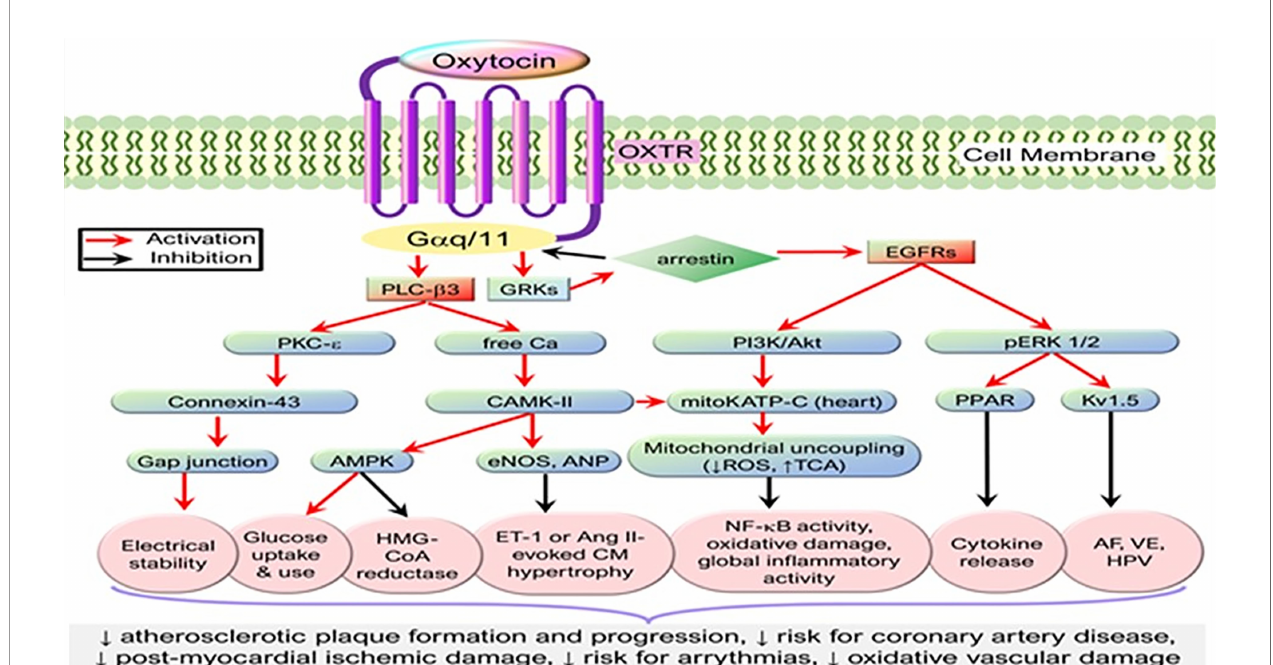
FIGURE 3 | Simpli fi ed cardioprotective signaling pathways of oxytocin. Oxytocin via its G-protein coupled receptors triggers the PLC- b 3 pathway and GRKs that cross- activate EGFR while activating their downstream signaling molecules, resulting in the activation of CAMK-AMPK, PKC- ϵ , PI3K/Akt, and pERK1/2 signaling cascades. These signaling cascades mediate cardioprotective functions such as stabilizing electrical activity, alleviating metabolic derangements, and inhibiting in fl ammation or oxidative stress. AF, atrial fi brillation; Akt, protein kinase B; AMPK, AMP-activated protein kinase; ANP, atrial natriuretic peptide; Ang, Angiotensin; CaMK, Ca2+/calmodulin-dependent protein kinase; EGFR, epidermal growth factor receptor; eNOS, endothelial nitric oxide synthase; ET-1, endothelin-1; GRK, G protein-coupled receptor kinase; HMG-CoA reductase, 3-hydroxy-3-methyl-glutaryl-coenzyme A reductase; HPV, hypoxic pulmonary vasoconstriction; Kv1.5, voltage-gated potassium channel Kv1.5; mKATP C, mitochondrial ATP-dependent potassium channels; OXTR, Oxytocin receptor; PI3K, phosphatidylinositol 3-kinases; PLC- b 3, phospholipase C- b 3; PKC, protein kinase C; TCA, tricarboxylic acid cycle; VE, ventricular ectopy. [Figure originates and adapted from articles (61 – 64)]. The down arrow symbol ( ↓ ) refers to decrease i.e. decrease in the pathology